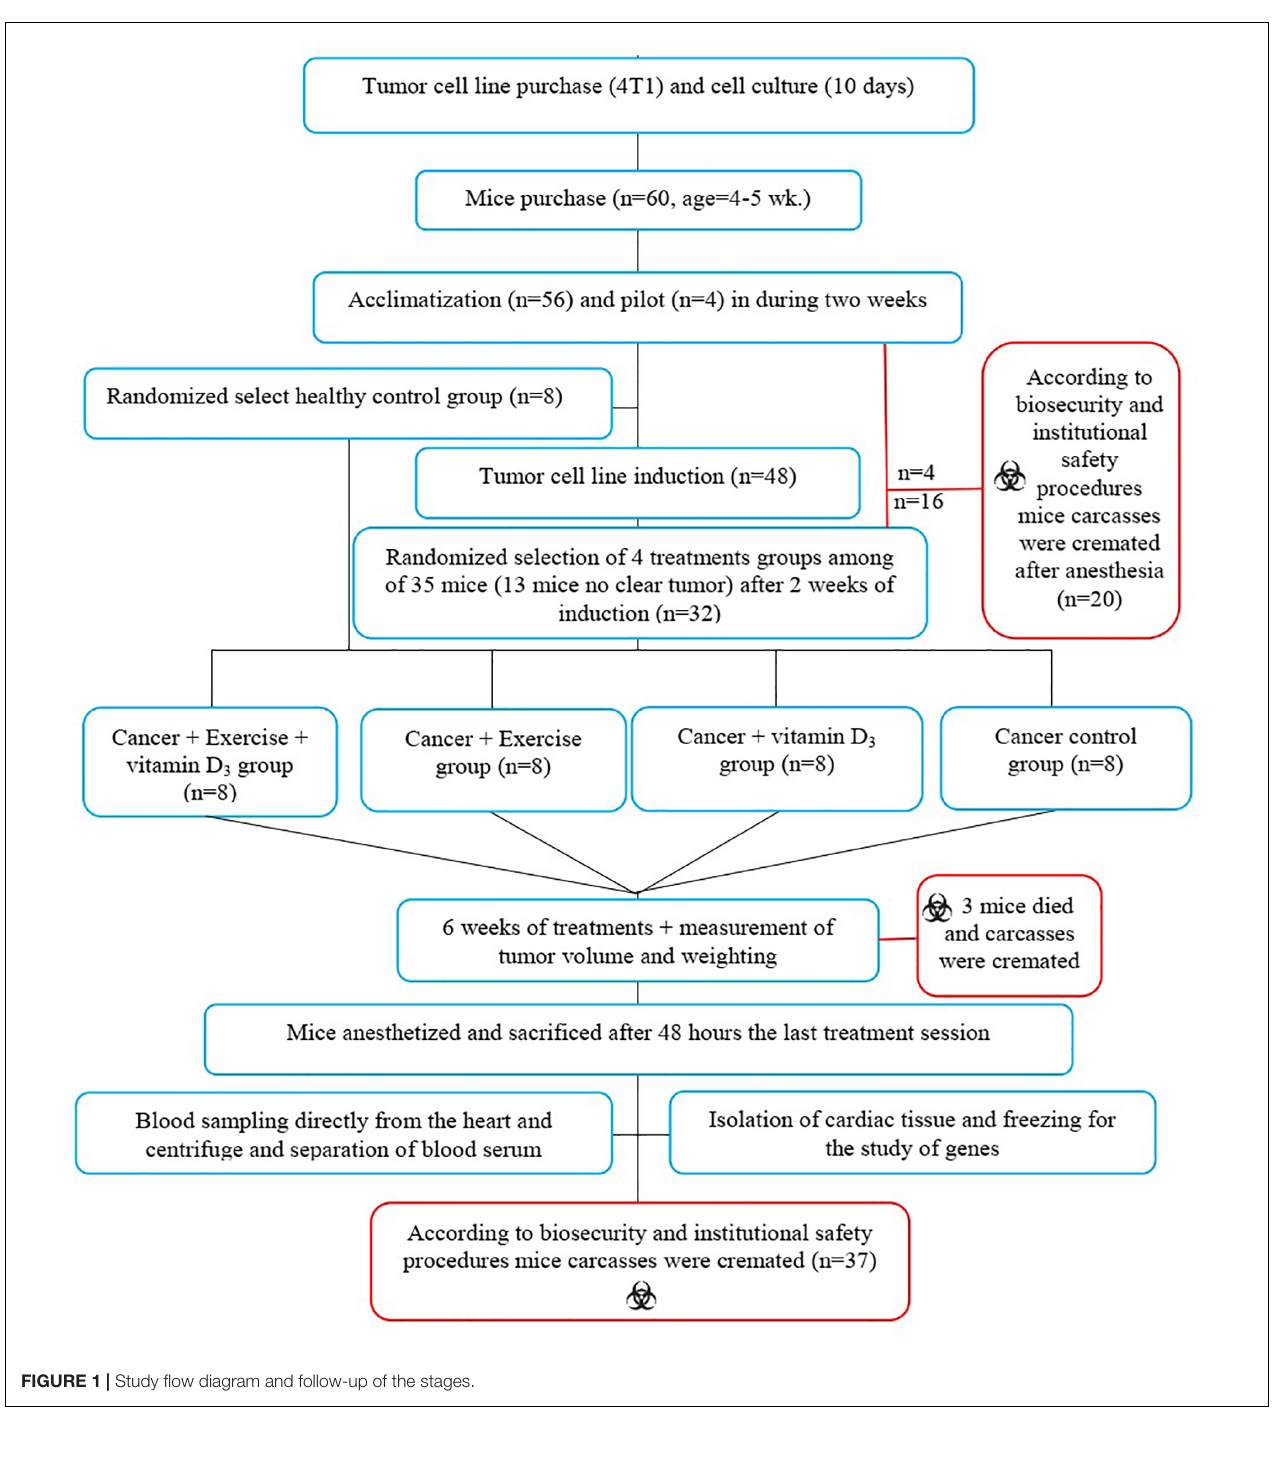
250 µ l of chloroform and 1 ml of RNX-PLUS solution were added and incubated for 5 min. The mixture was then centrifuged at 12,000 r/min for 15 min at 4 ◦ C. Total RNA was transferred to an RNase-free situation, and 300 µ l of isopropanol was added. After several steps of washing and RNA separation, the extracted RNA was read by a spectrophotometer (NanoDrop ND-1000;